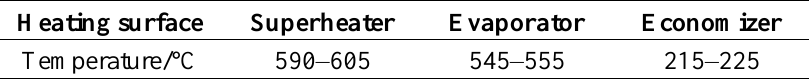
Table 6. Inlet flue gas temperatures of the heating surfaces.